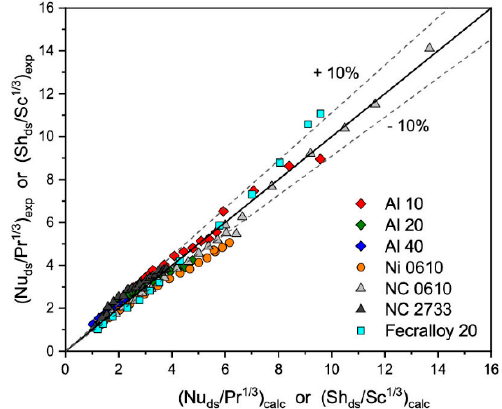
Figure 4. Experimentally determined heat/mass transfer and that calculated based on equation (3) with a = 0.489 and b = 0.552 and d s as characteristic diameter.